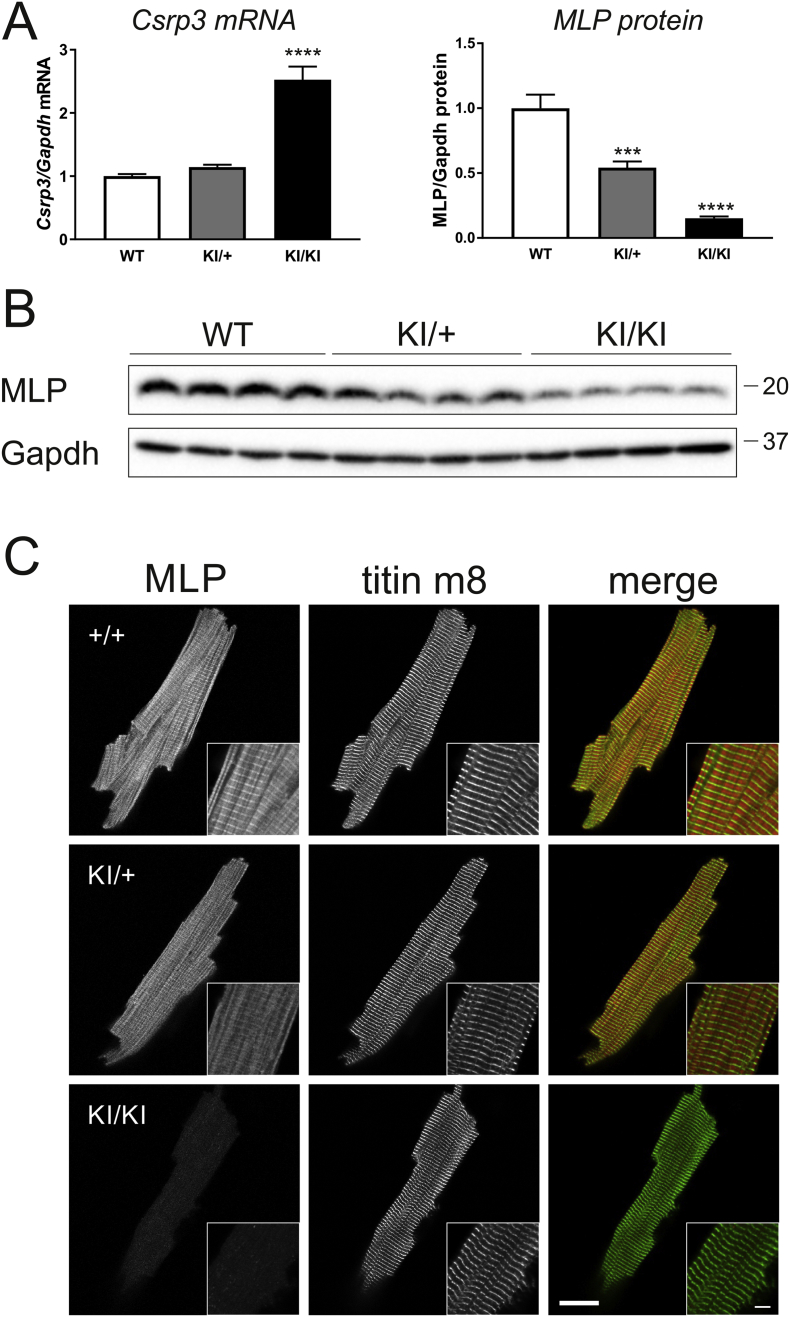
MLP depletion in KI/KI hearts. A – Measurement of Csrp3 transcript by qPCR (left) and MLP protein (right) in the three groups, normalised to Gapdh transcript and protein, respectively. In the KI/KI mice, Csrp3 transcript is 2.5-fold up-regulated. The abundance of MLP decreased in KI/KI mice by 80% and in KI/+ mice by 50%. MLP level is down-regulated to 50% in KI/+ mice and to 20% in KI/KI mice. ***p < 0.001, ****p < 0.0001 versus WT, n = 6 per group. B – Representative Western blot demonstrating reduced MLP levels in KI/+ and KI/KI mice. Gapdh serves as loading control. The position of marker proteins is indicated (molecular weight in kDa). N.B., both TaqMan probe target site and epitope of the anti-MLP antibody 79D2 are not overlapping with the site of the C58G mutation. C – Immuno-fluorescence on isolated adult cardiomyocytes from mice of the three genotype groups. Cells are stained for MLP (left), titin M-band epitope m8 (middle) and merged images are shown on the right (MLP red, titin m8 green). Scale bar represents 20 μm. Insert: Magnified area, scale bar represents 5 μm.